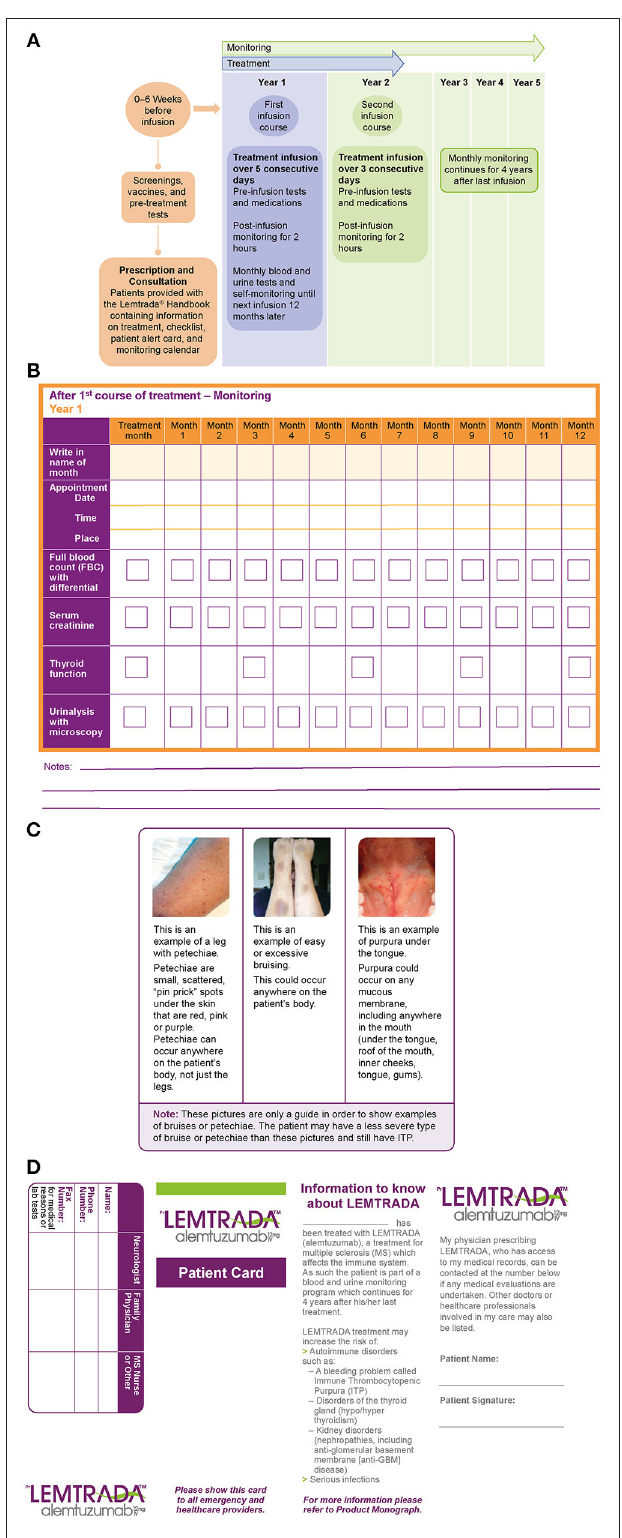
FIGURE 1 | (A) Alemtuzumab dosing regimen and monitoring, (B) patient monitoring calendar, (C) patient reference guide with examples of immune thrombocytopenia (ITP) skin conditions, and (D) patient alert